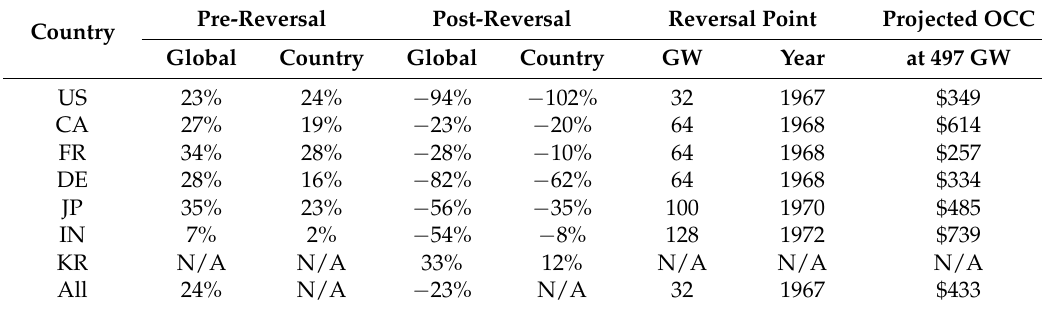
Table 1. Learning rates for pre-reversal and post-reversal, selected reversal point and projected overnight construction cost at 497 GW cumulative global capacity of construction